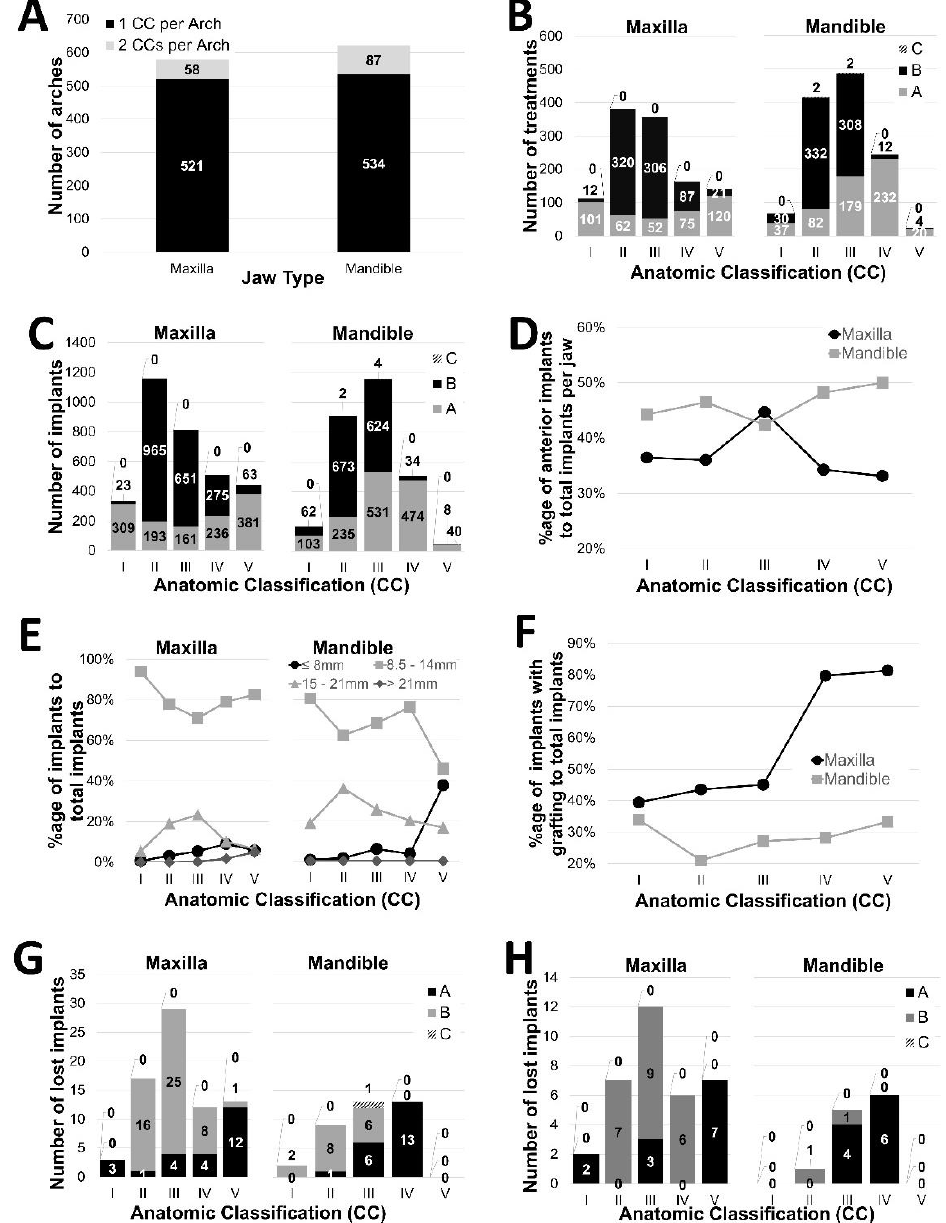
Figure 2. ( A ) Number of different CCs per maxillary and mandibular arch. ( B , C ) Total number of treatments ( B ) and implants ( C ) per treatment category. ( D ) Relative %age of anterior implants to total implants per CC. ( E ) Relative distribution of implants per CC as a function of implant length (short implants (≤8 mm), regular implants (8 – 14 mm), long implants (15 – 21 mm) and zygomatic implants (>21 mm)). ( F ) Frequency of bone grafting per CC. ( G , H ) Total number of failed implants ( H ) and total number of failed implants in patients that lost ≥ two implants ( G ) as a function of TC, respectively.